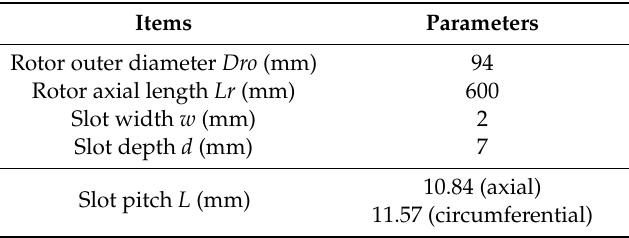
Figure 2. Structure of SSR. Table 2. Parameters of SSR.